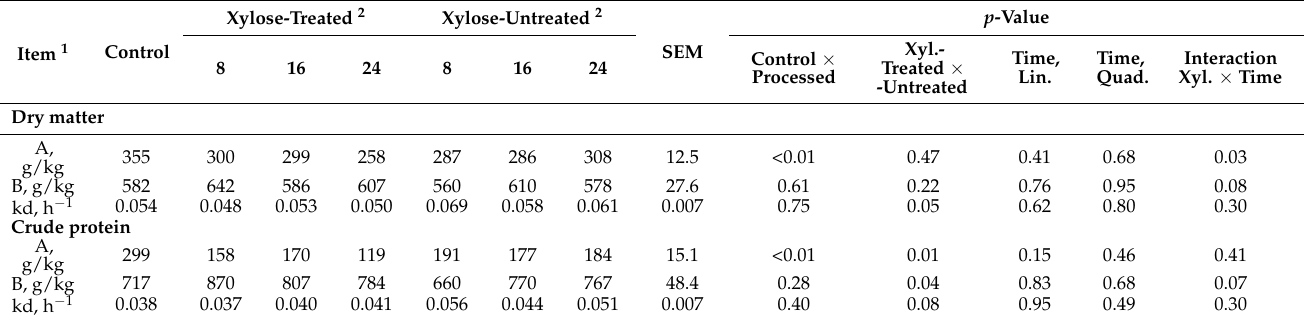
Table 4. Effects of autoclave and xylose inclusion on rumen degradation parameters of peanut meal.